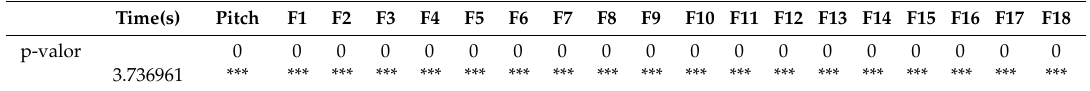
Table 5. The results of the correlation between the reference audio, for Sentence #1, with itself. Time(s)